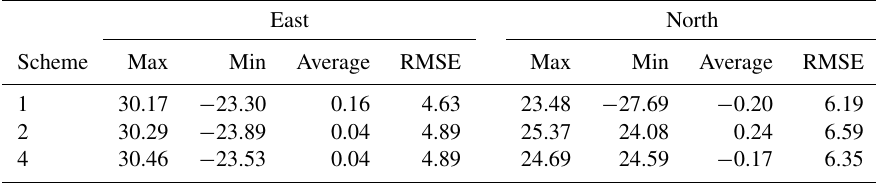
Table 4. Internal precision of the Euler vectors (mmyr − 1 ).